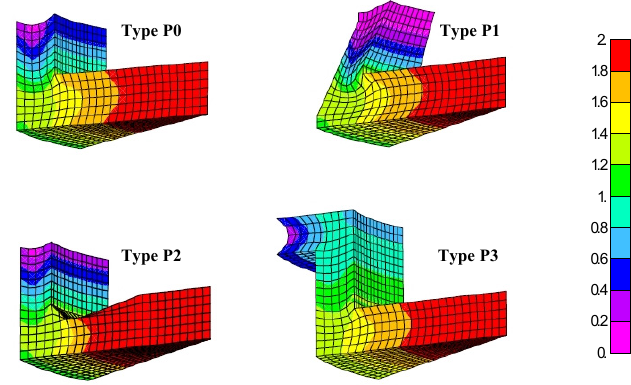
Figure 9: Maximum principal stresses for tensile